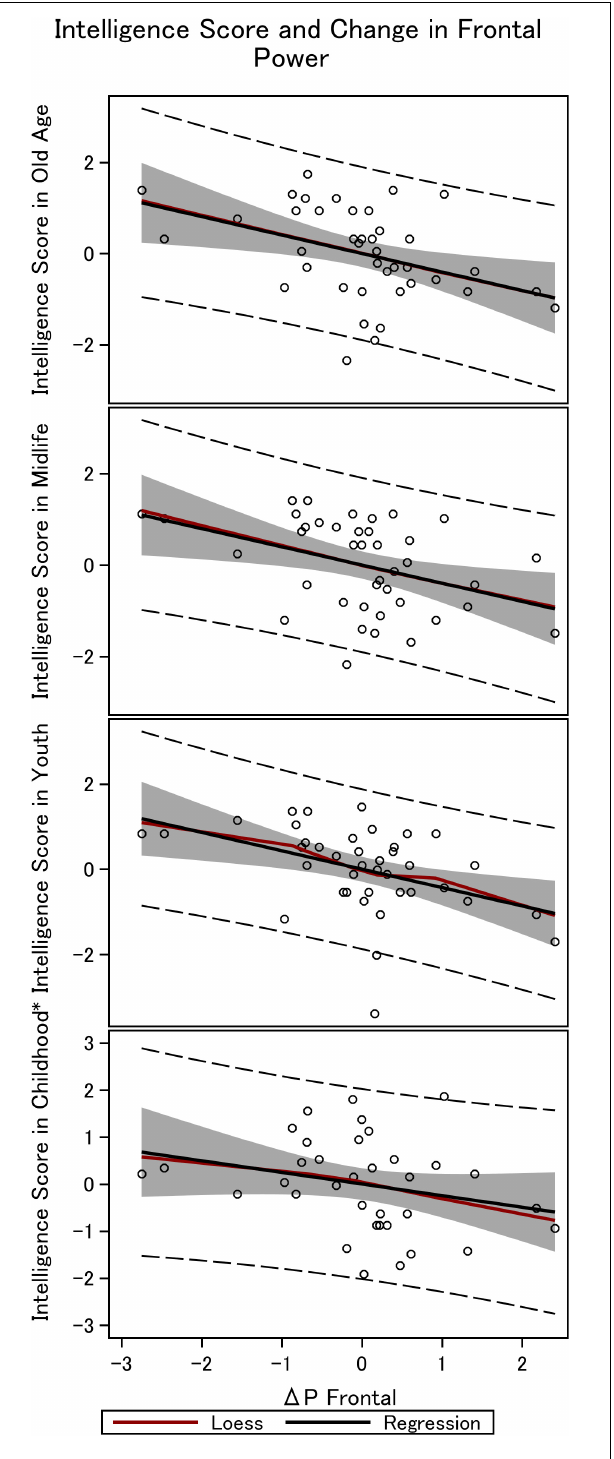
FIGURE 4 | Frontal steady state gamma power and intelligence in the 36 men. The figure depicts the linear fit between intelligence obtained in childhood ( ∼ 12 years), youth ( ∼ 20 years), midlife ( ∼ 56 years), and elderly age ( ∼ 62 years), and the difference in power between mono and double-sensory stimulation when investigating the visual response. ∗ Smaller sample size ( N =